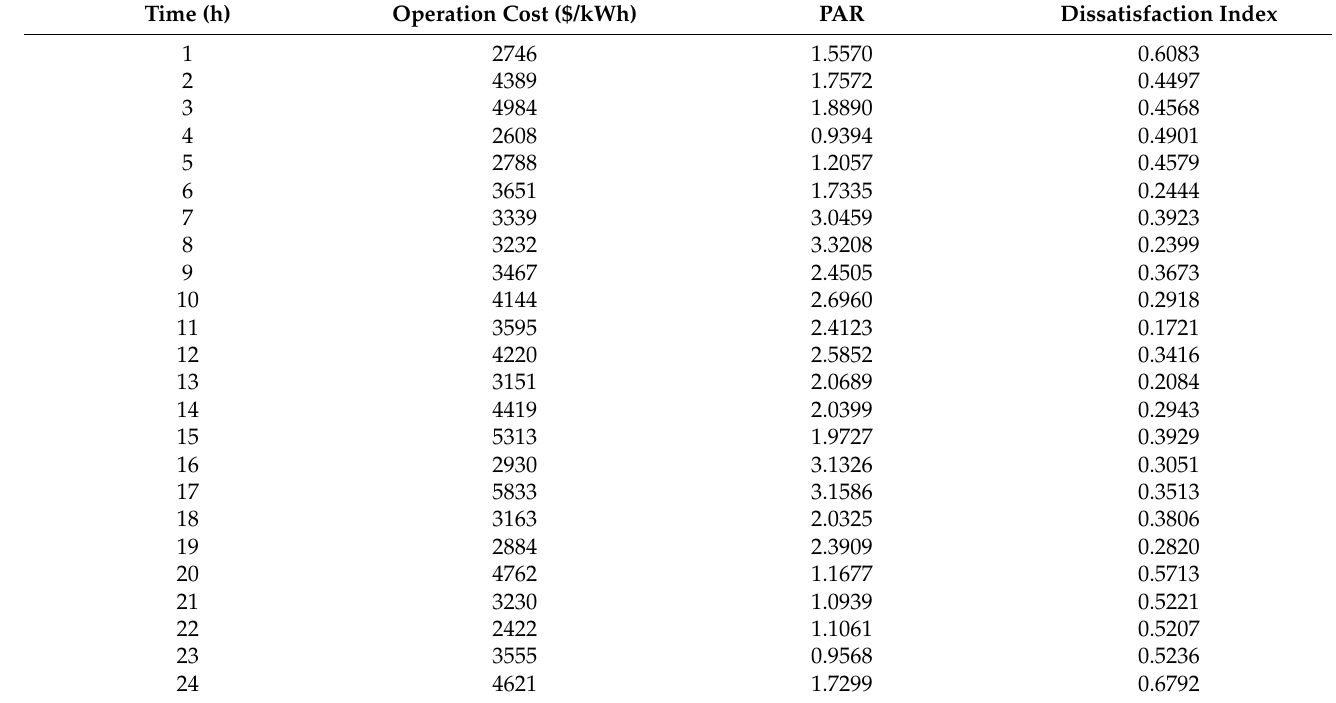
Table 5. A summary of results of three objective functions.